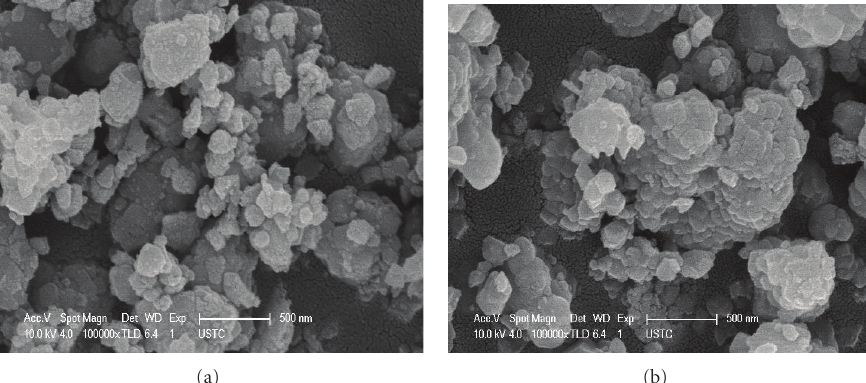
Figure 2: SEM images of CuO (1.0 wt.%)/F-TiO 2 photocatalysts. (a) CuO (1.0 wt.%)/F-TiO 2 , ball milling time 6h, (b) CuO (1.0 wt.%)/F- TiO 2 , ball milling time 24 h.